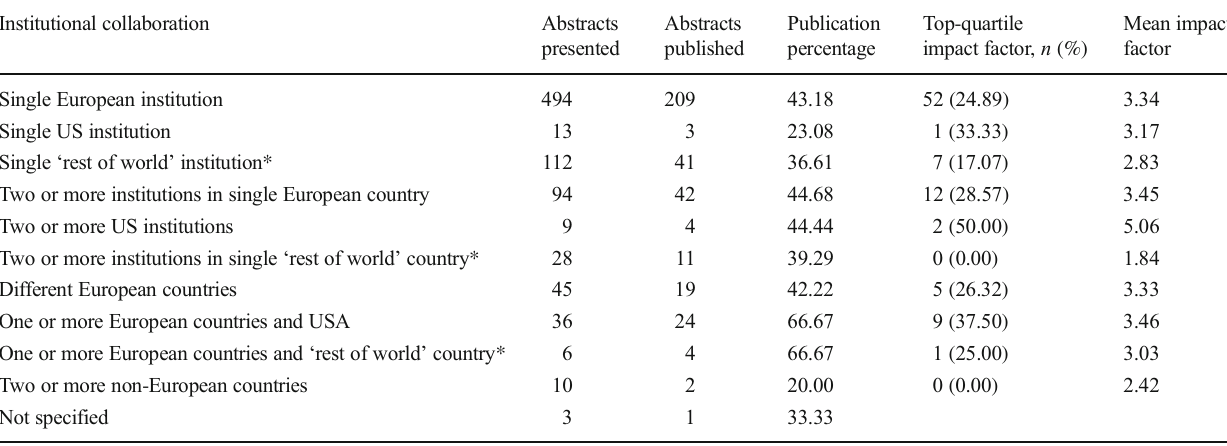
Rates of conversion of orally presented abstracts into publications according to collaboration